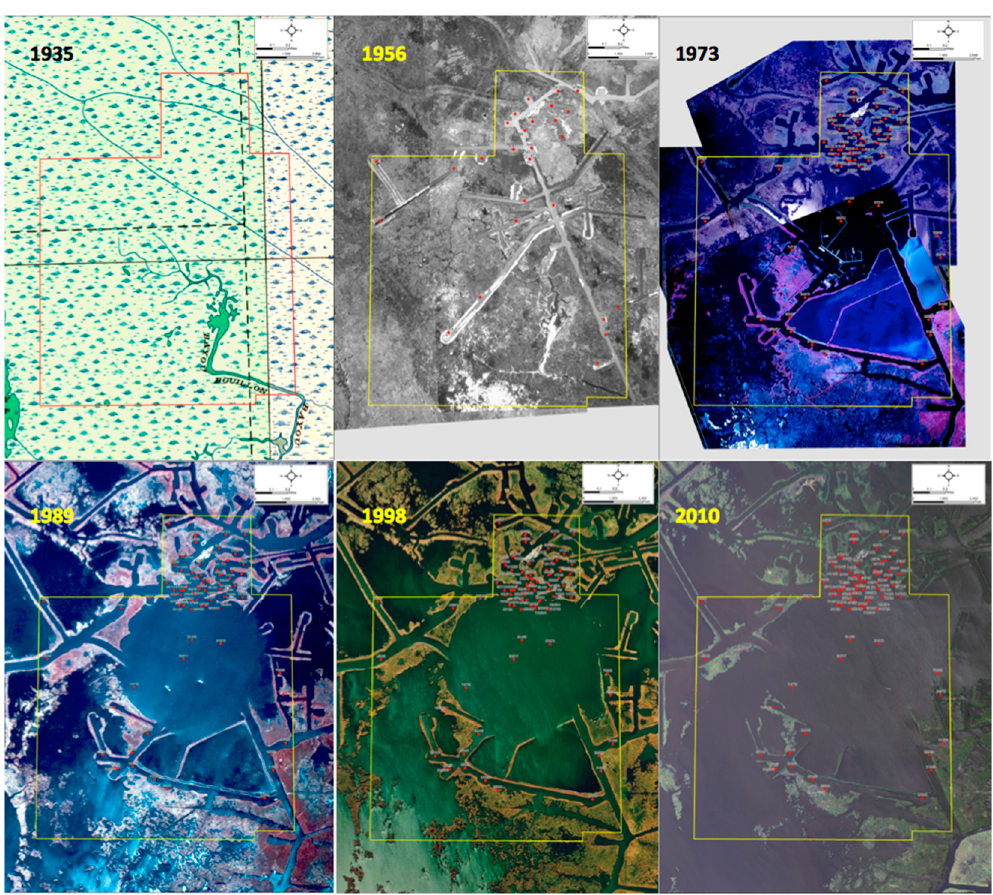
Figure 18. Images of the Bully Camp oil and gas field over time. The yellow line denotes an ownership tract in the field and red dots show locations of oil and gas wells. Note that land loss has been pervasive over the general area of the field. The central water body in the 1989 image is over an area of sulfur production on the top of the salt dome underlying this field. The narrow blue lines in the 1935 map are abandoned minor distributary ridges that were breached by canals (images from [76]).